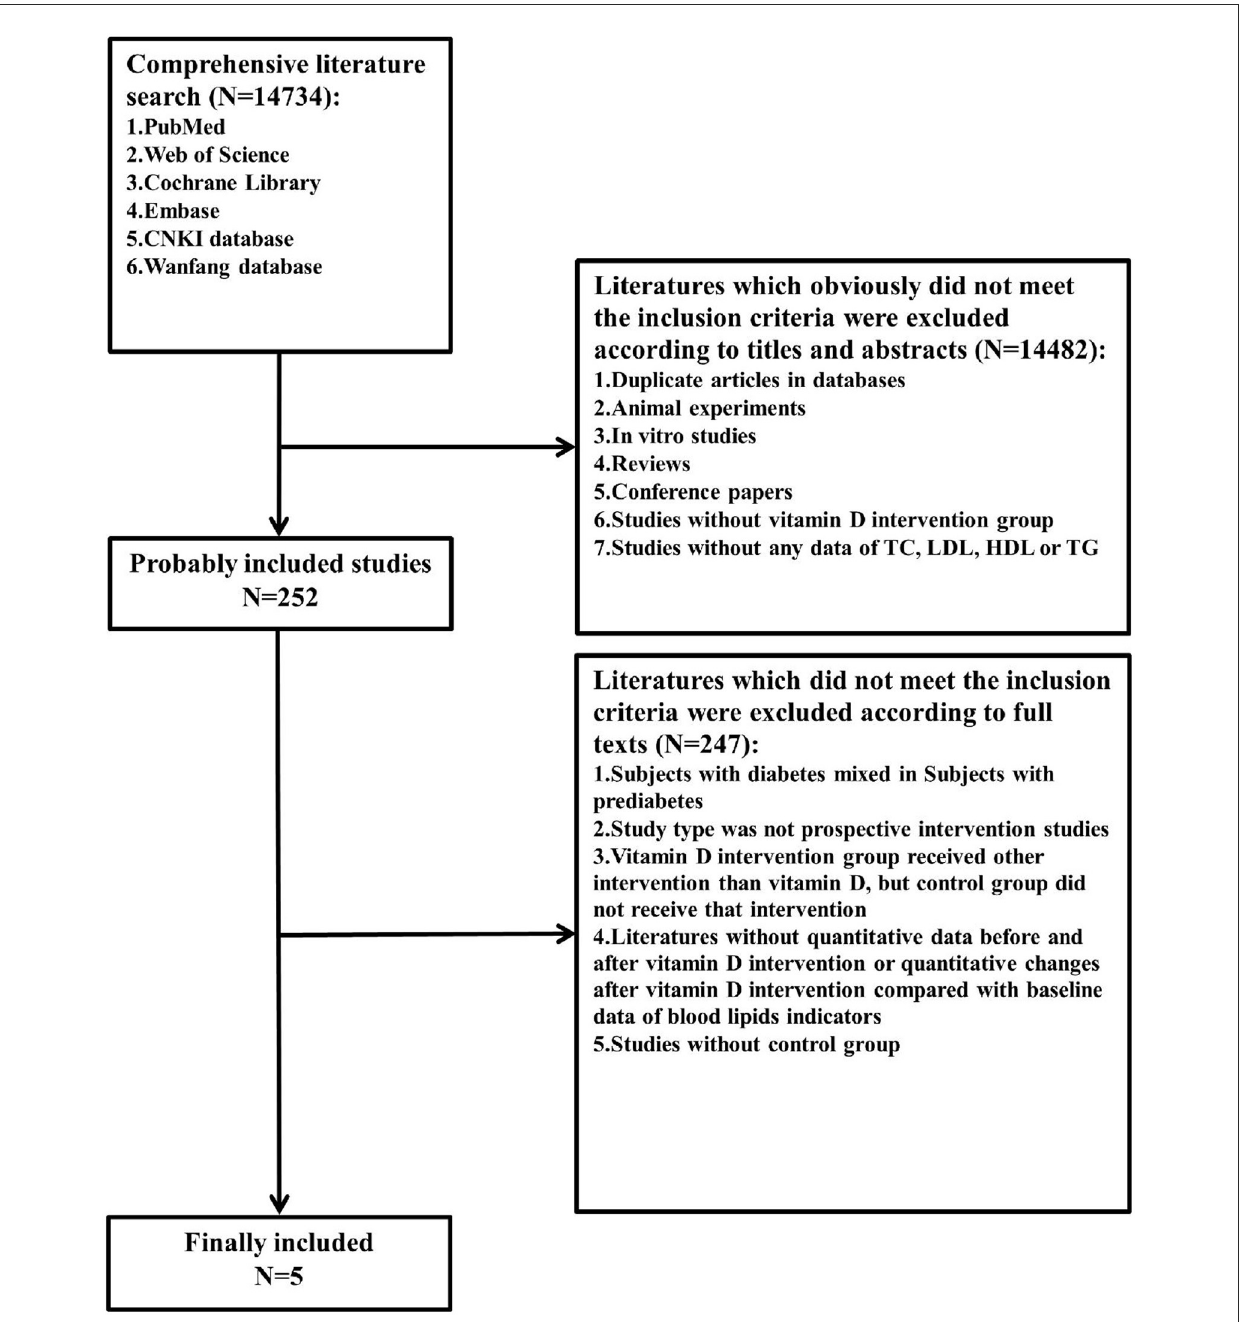
FIGURE1 Flow diagram of the literature search and selection. TC, total cholesterol; LDL-C, low-density lipoprotein cholesterol; HDL-C, high-density lipoprotein cholesterol; TG, triglyceride.